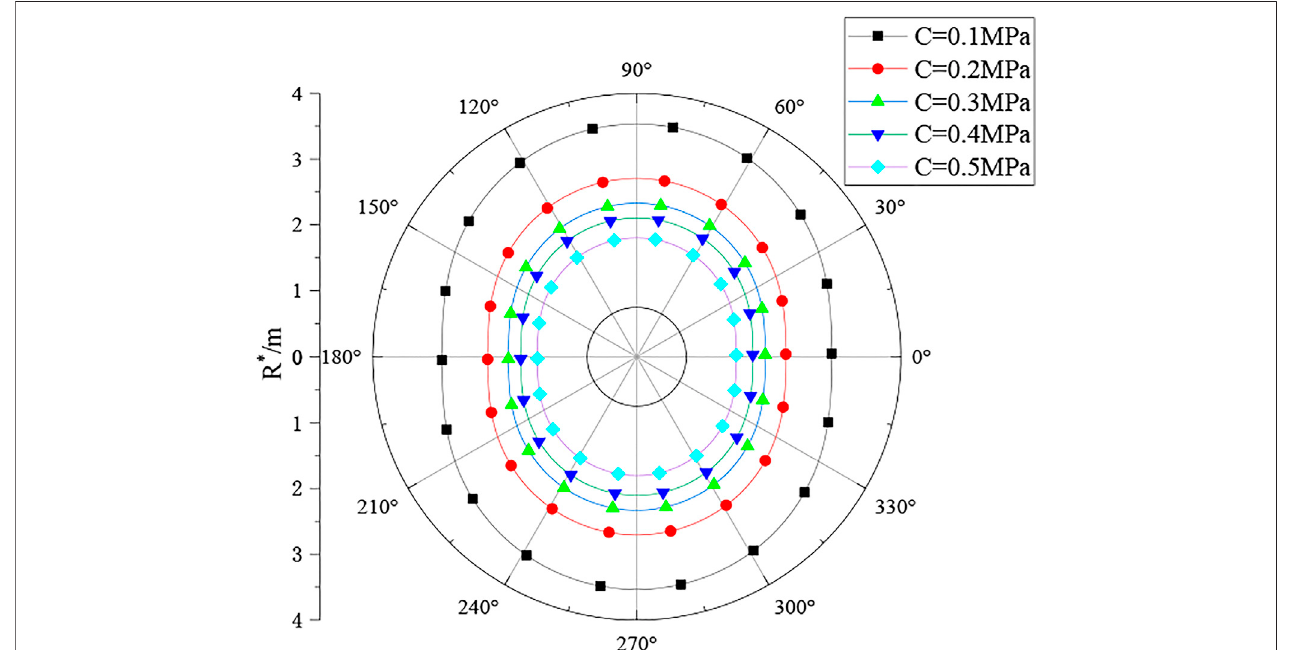
FIGURE 5 | Radius distribution of plastic zone around hydraulic reaming.